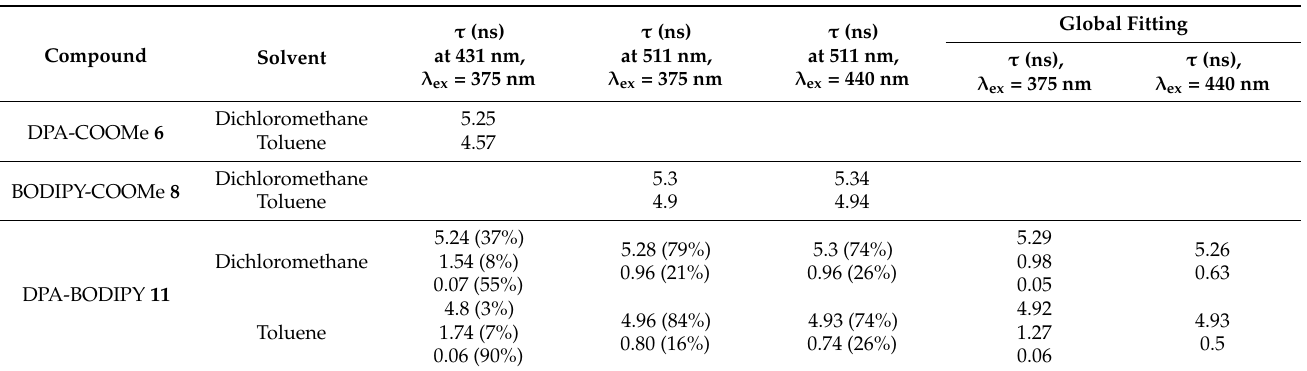
Table 2. The results of analysis of fluorescence decay kinetics of compounds 6 , 8 and 11